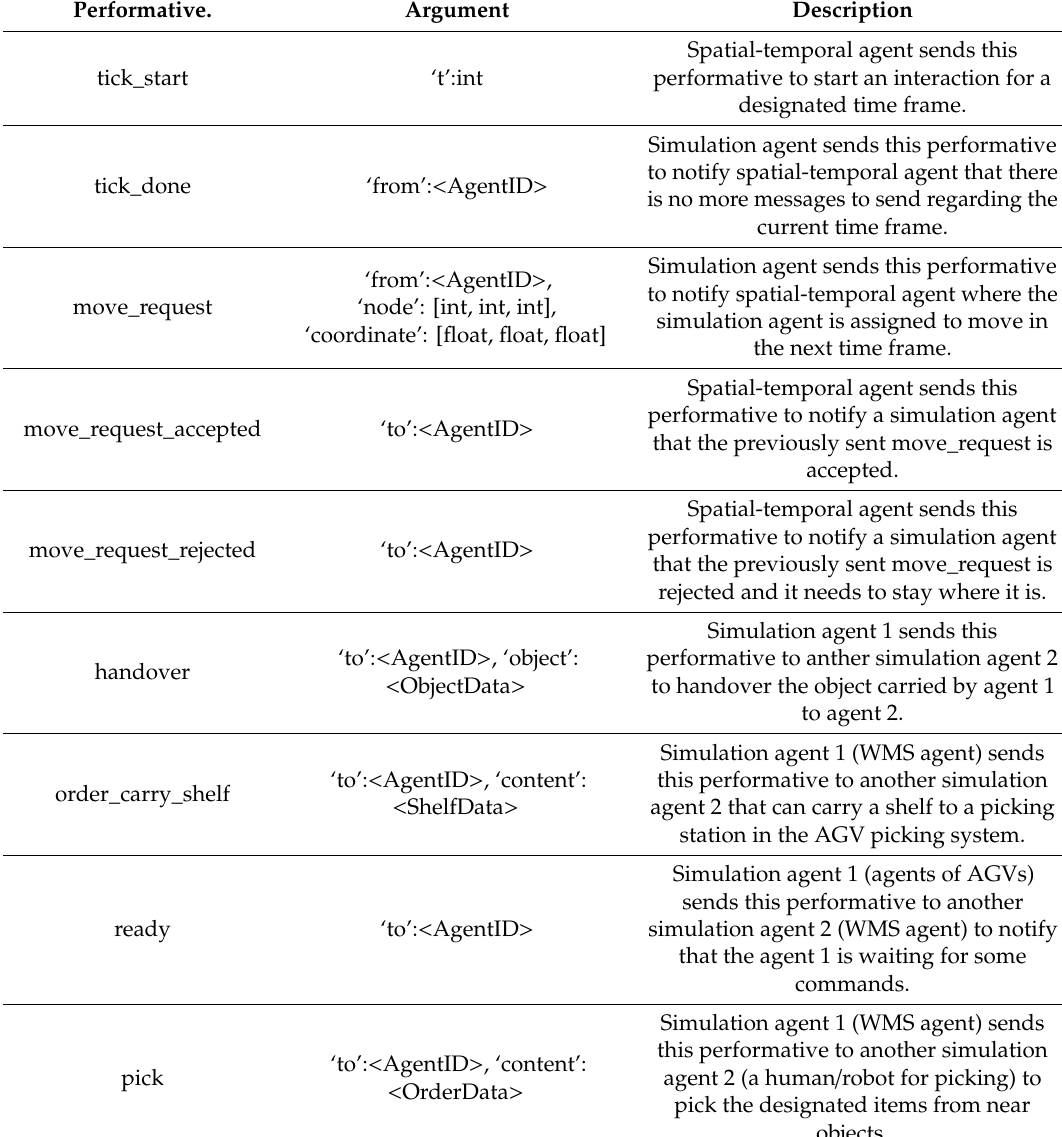
Table 1. Performatives for logistics